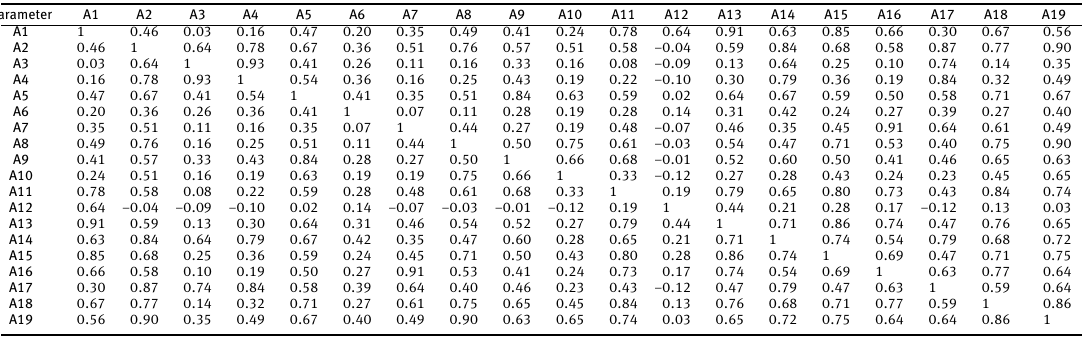
Table 6: Empirical correlations between original losses in adjacent areas. Parameter